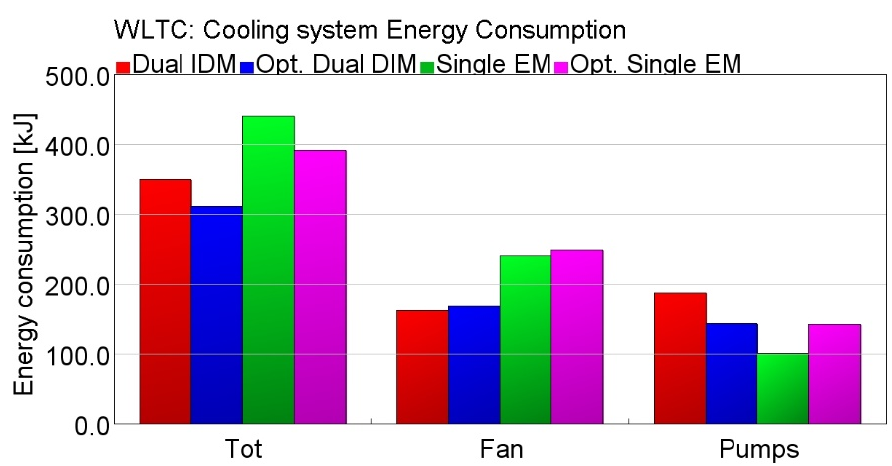
Figure 17. Impact of modularity and optimized control strategy on the energy consumption reduction for the WLTC driving cycle.